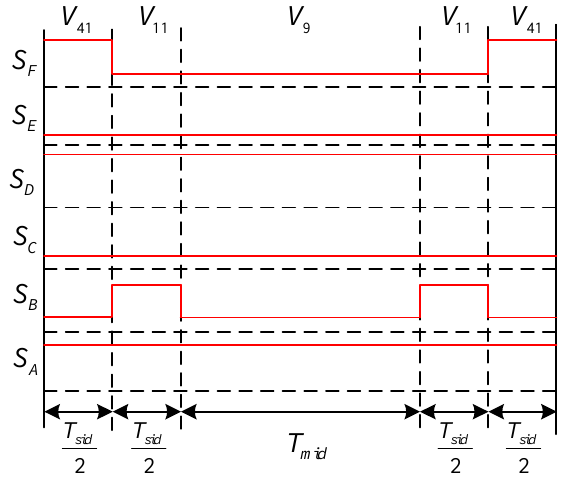
Figure 13. Switch sequence during M 1 synthesis.